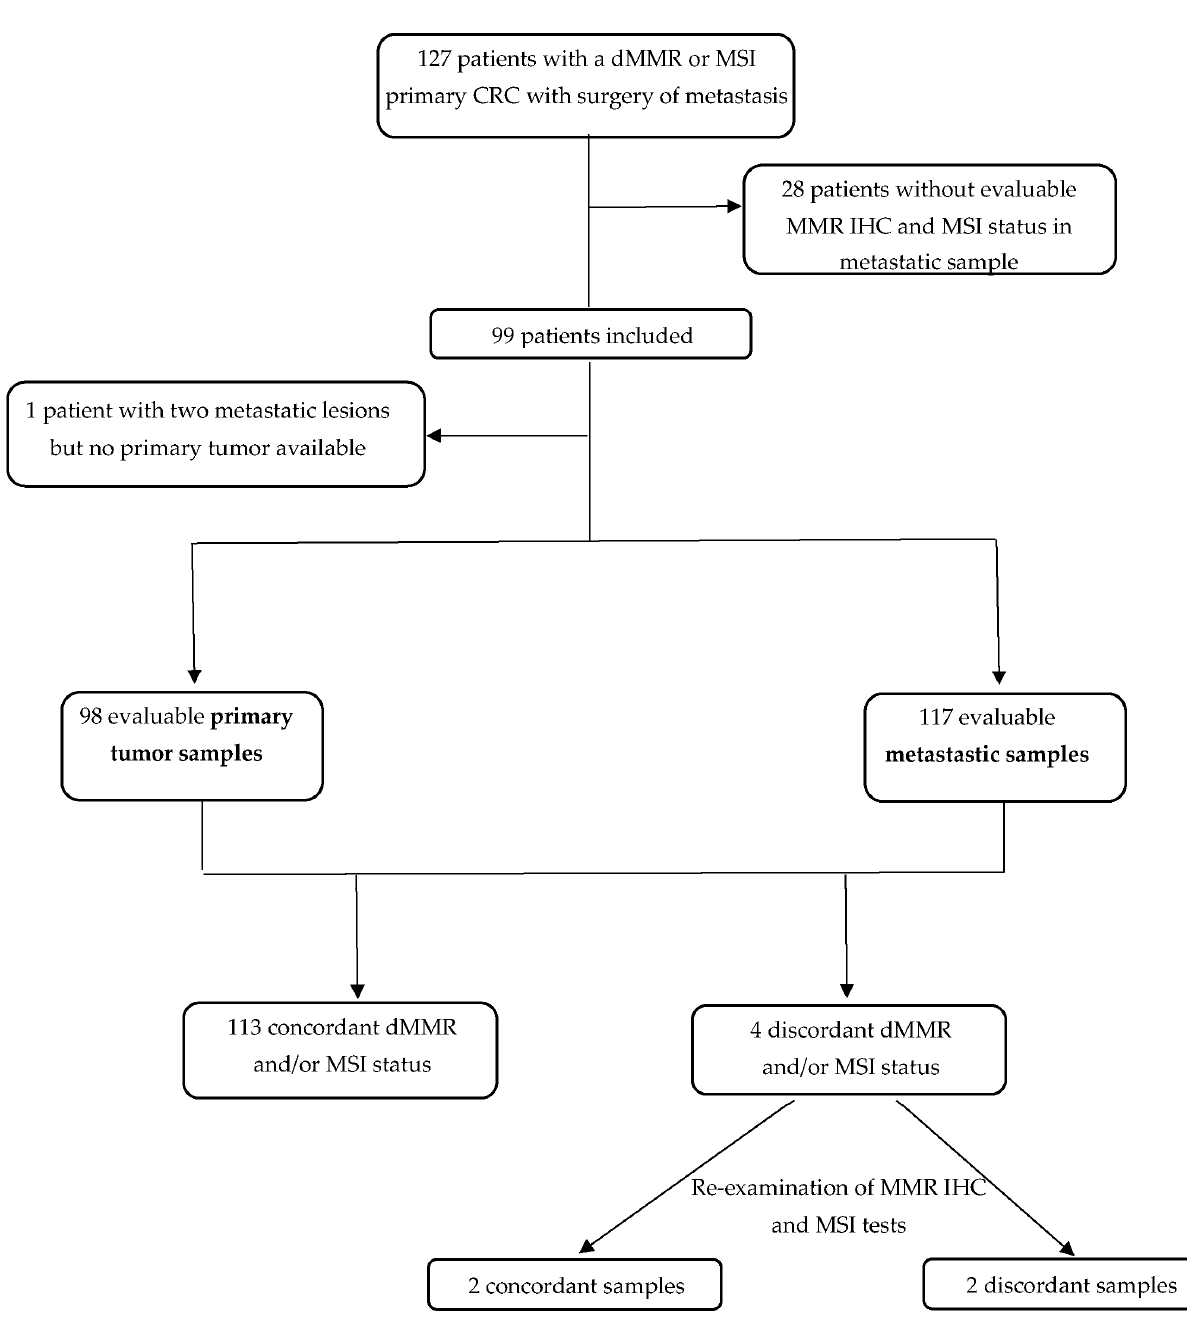
Figure 1. Flow chart. CRC: colorectal cancer; IHC: immunohistochemistry; MMR: mismatch